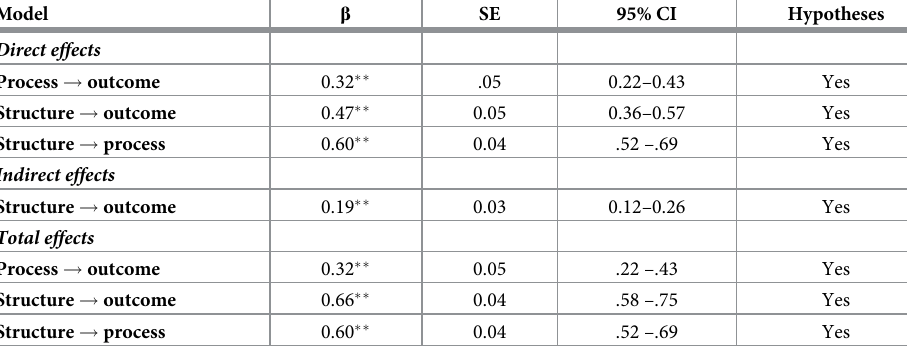
Table 5. Path analysis of mediation effects of structure and process on the